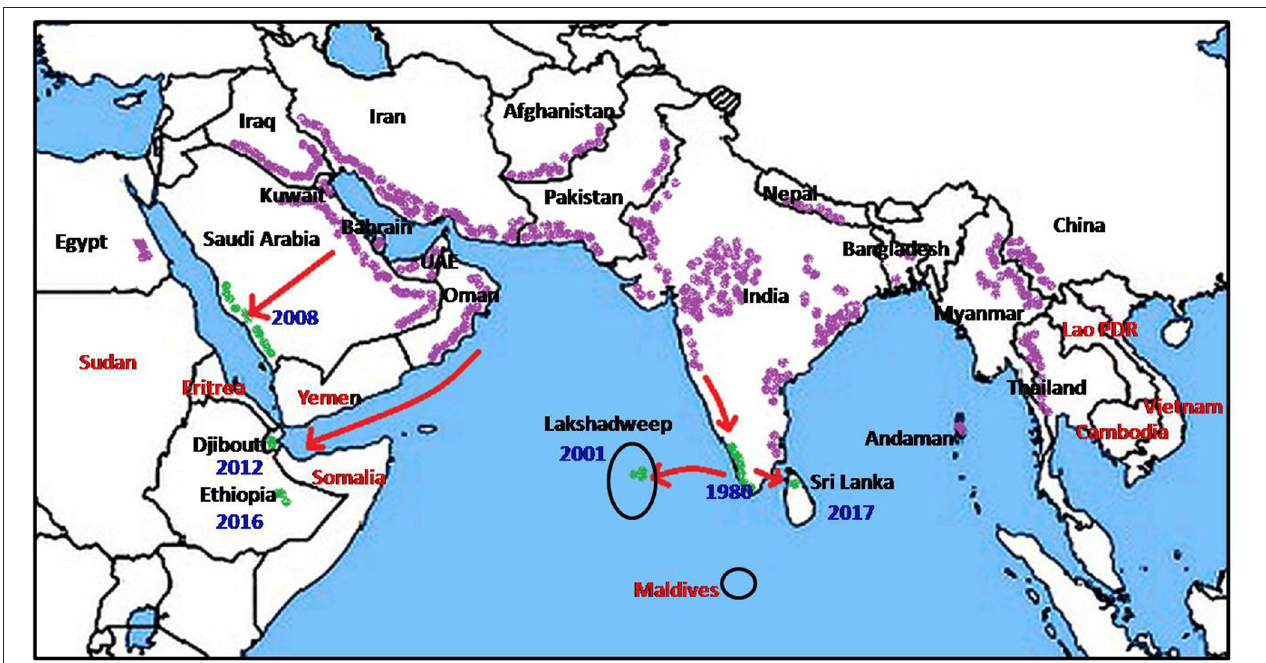
FIGURE 2 | The map of (a) the island of Sri Lanka in the Indian Ocean, and (b) sampling sites in Mannar and Jaffna. The solid red circles indicate the southward expansion of An. stephensi into South India, Lakshadweep islands, and Sri Lanka.